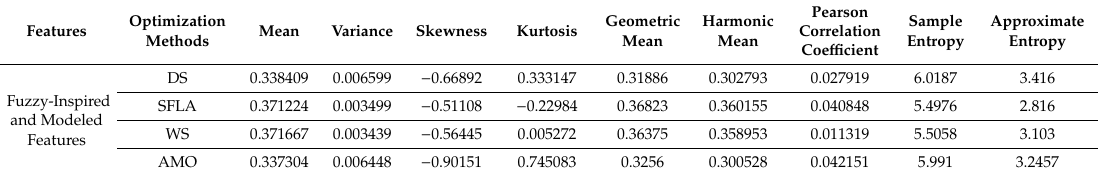
Pearson Sample Approximate Correlation Entropy Entropy Coe ffi cient